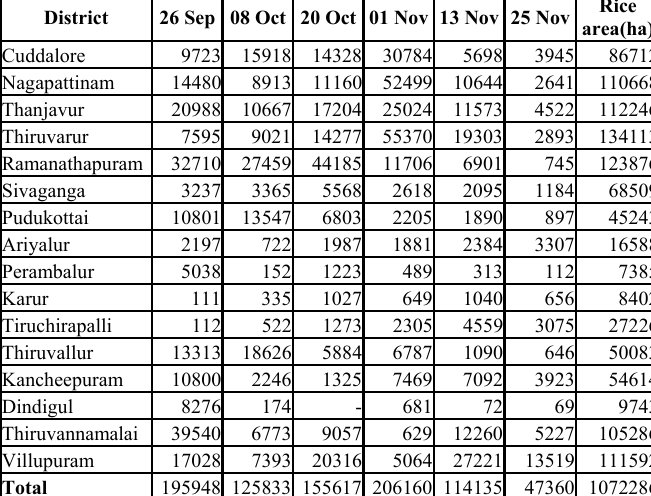
Fig. 1. Rice area map – Cauvery delta region, TamilNadu, India Table 1.Summary of site validation visits, rice area and accuracy assessments.